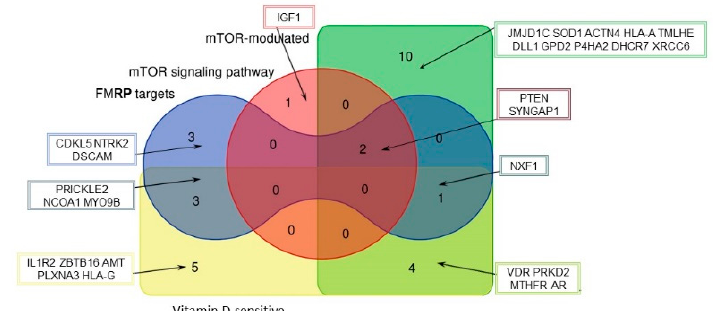
Figure 3. Venn diagram representing the complete intersection of ASD and AID genes of the four categories related to the mTOR signaling and vitamin D-sensitive genes.